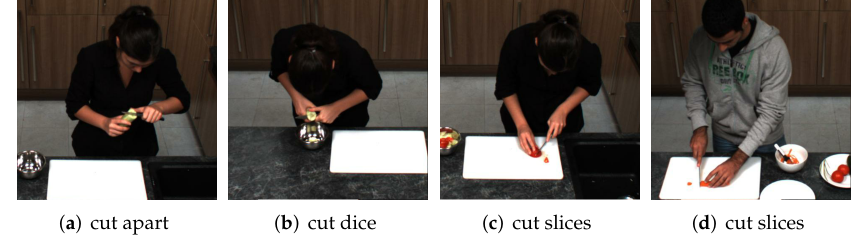
Figure 1. Some exemplars of fine-grained actions in MPII cooking database. ( a ) cut apart, ( b ) cut dice, ( c ) cut slices, and ( d ) cut